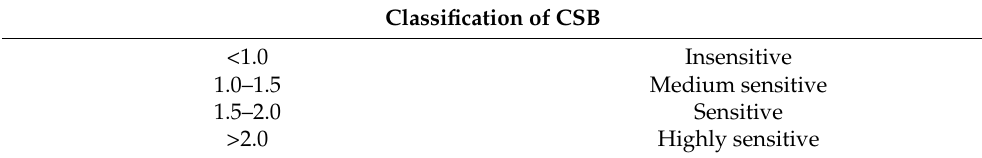
Table 17. Classification of drying sensitivity according to Bigot’s CSB index.